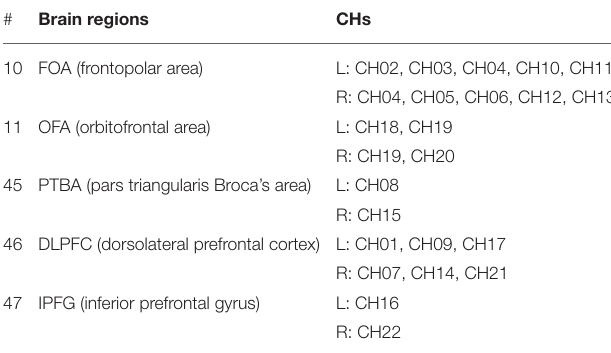
TABLE 1 | ROI-channel